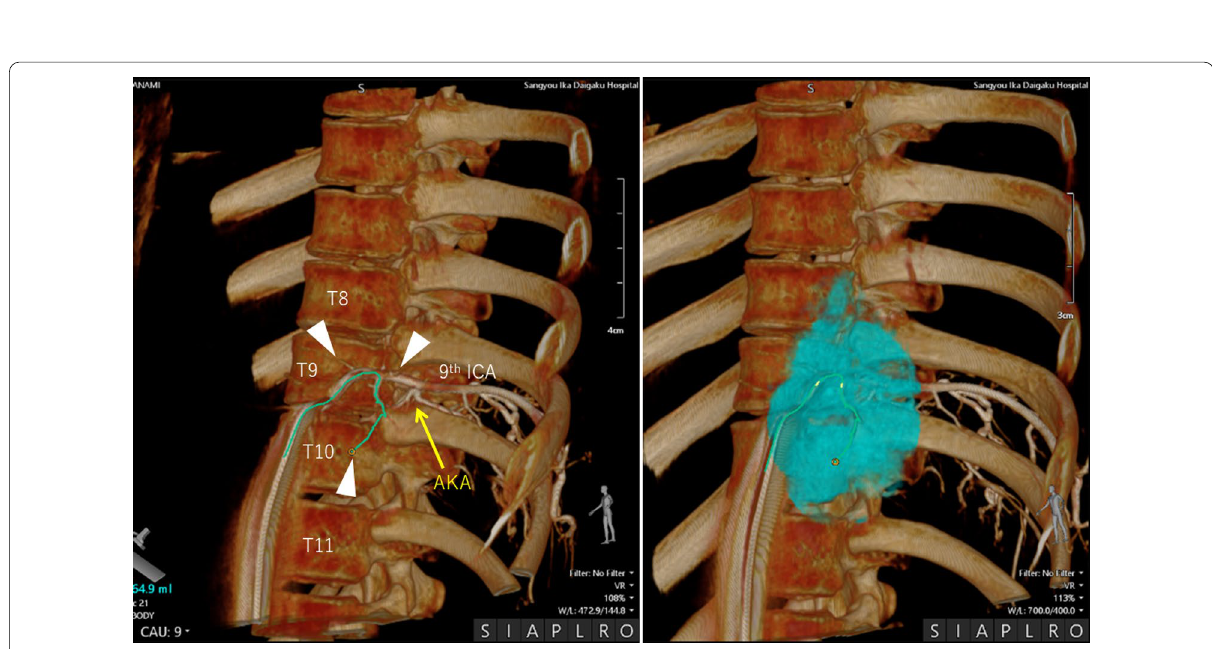
Fig. 3 Digital subtraction angiography showed that tumor-feeding arteries (white arrows) and the artery of Adamkiewicz arose from the 9th intercostal artery. AKA, artery of Adamkiewicz; ICA, intercostal artery; T8, 8th thoracic vertebra; T9, 9th thoracic vertebra; T10, 10th thoracic vertebra; T11, 11th thoracic